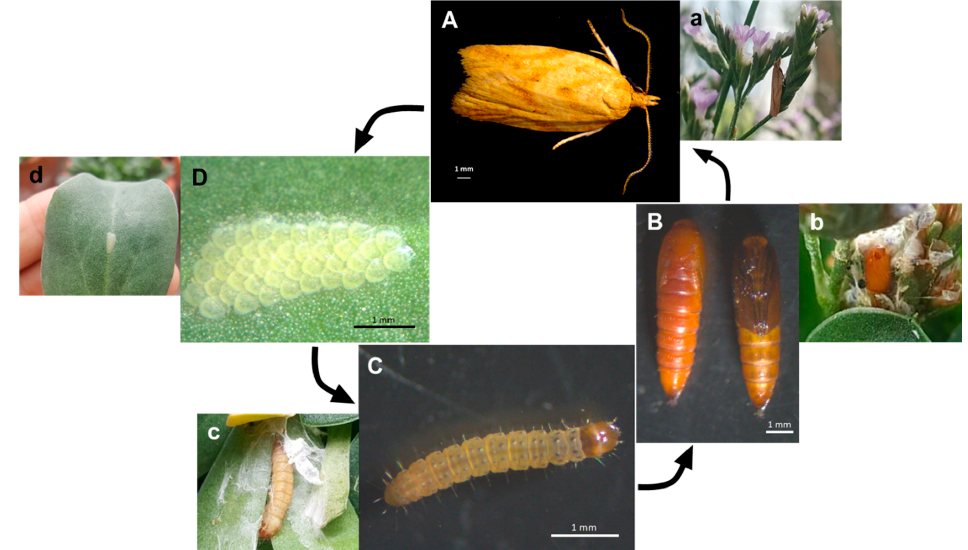
Figure 3. Life cycle of Clepsis coriacana (Rebel) (Lepidoptera: Tortricidae) in Limonium inflorescences and leaves. ( A ) Male and female adults ( a ); ( B ) pupae and detail of a pupae ( b ); ( C ) larvae and larvae on leaves ( c ); ( D ) eggs’ cluster and eggs’ cluster on a leaf ( d ).